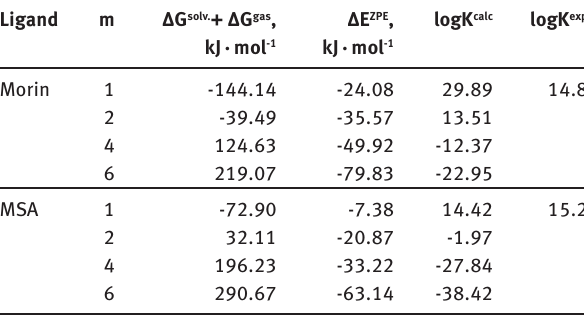
Table 3 : The results of quantum-chemical estimation. Ligand